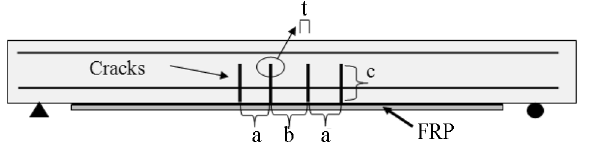
Fig. 10. Variables in crack definition